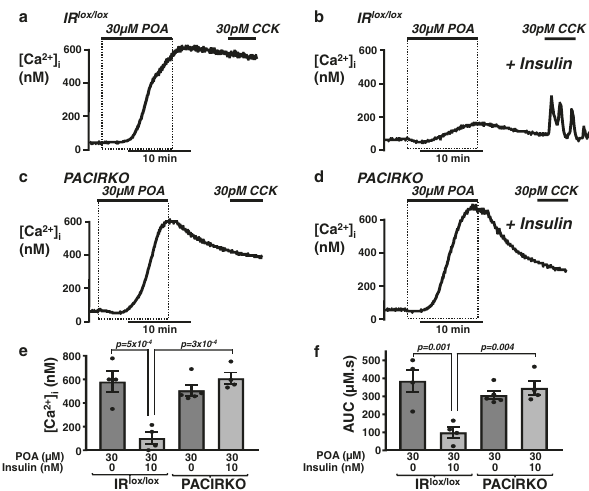
Fig. 5 Insulin-mediated protection against palmitoleic-induced Ca 2 + overload is abolished in pancreatic acinar cells from PACIRKO